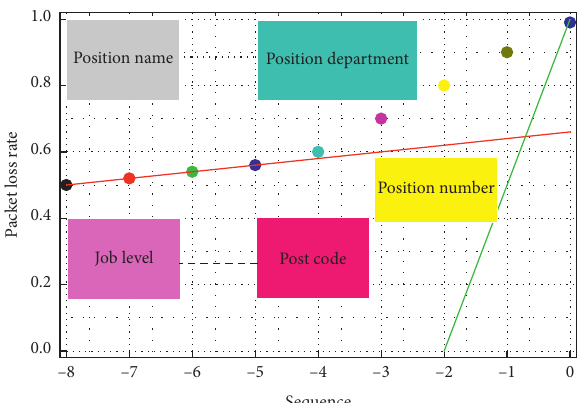
Figure 5: Job information statistics.